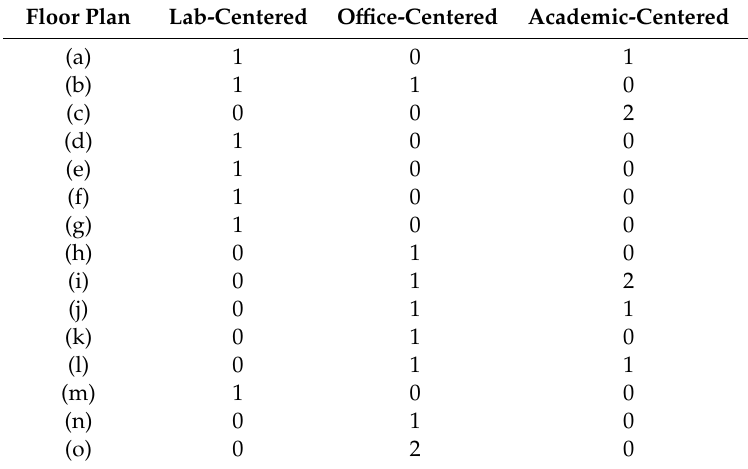
Figure 10. Distribution of test buildings. Table 1. The number of di ff erent types of building units in each floor